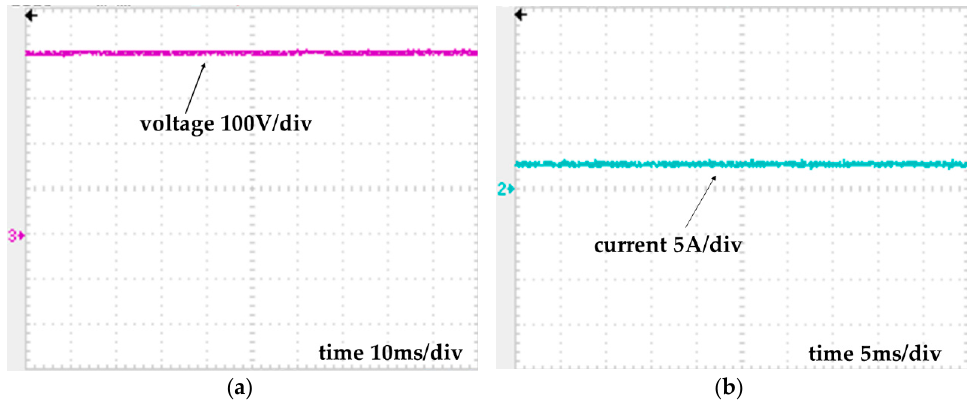
Figure 13. Operation at f = 40 Hz (v wind = 12 m/s): ( a ) output voltage; ( b ) load current.